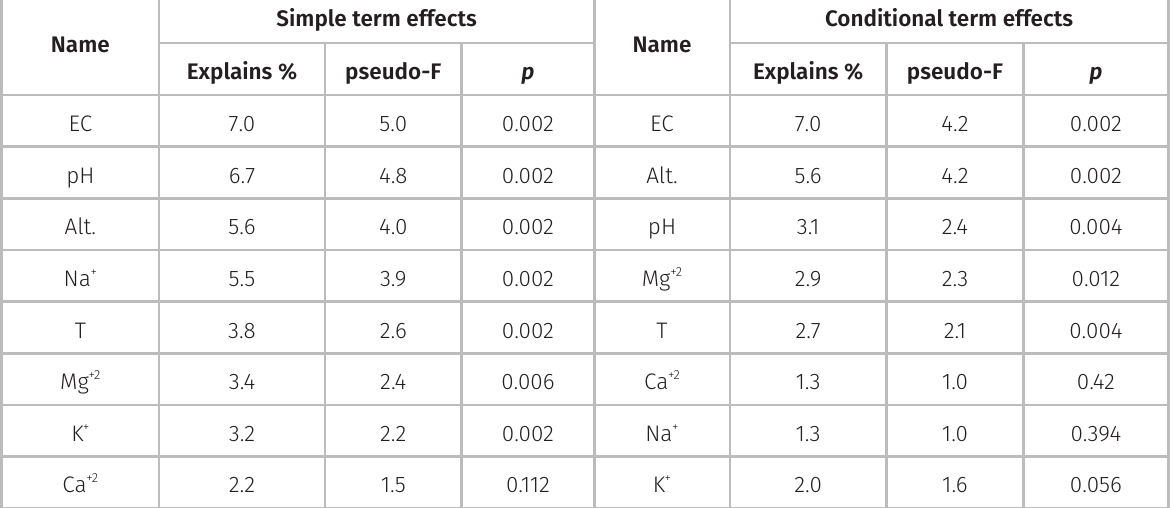
Table Vb. Main results of Canonical Correspondence Analyses (CCA) for ostracods presence/absence data based on the 69 sites of Patagonia. a) Sumary statistics for the first four axes of CCA. b) Ranking environmental variables in importance by their simple (left) and conditional (right) effects obtained by forward selection. p =significance level of the effect, as obtained with a Monte Carlo permutation test under the null model with 999 random